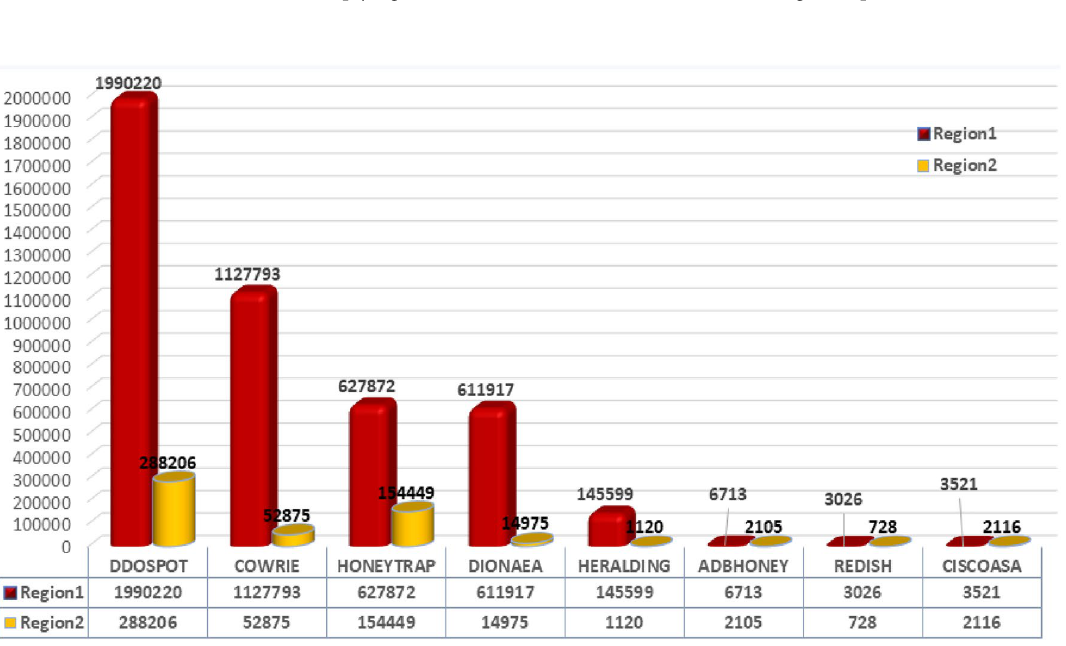
Figure 4. Attack statistics for Honeypot instances in experimental cloud